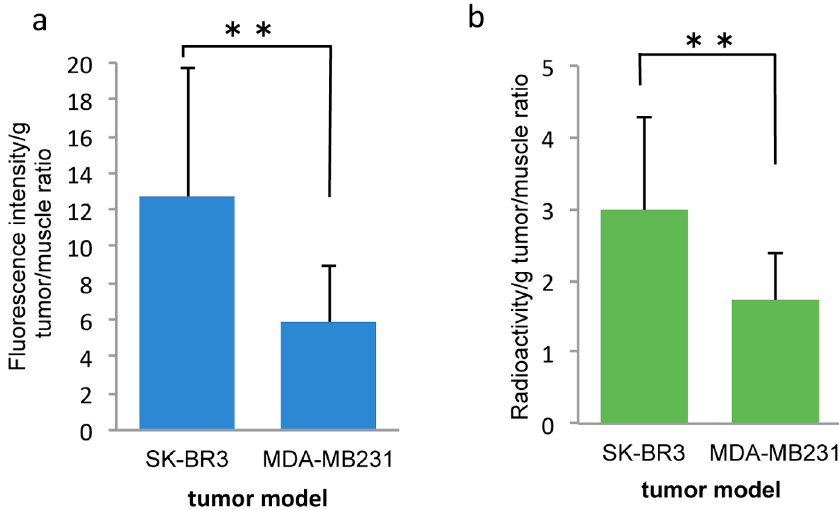
Figure 10. Comparison of fluorescence intensity and radioactivity in xenografted tumors on 99m Tc-DTPA dual-imaging probe studies. There were significant differences in fluorescence intensity and radioactivity between SK-BR3 tumors and MDA-MB231 tumors (SK-BR3, n = 13, MDA-MB231, n = 12) ( a , b ) (** p < 0.01).